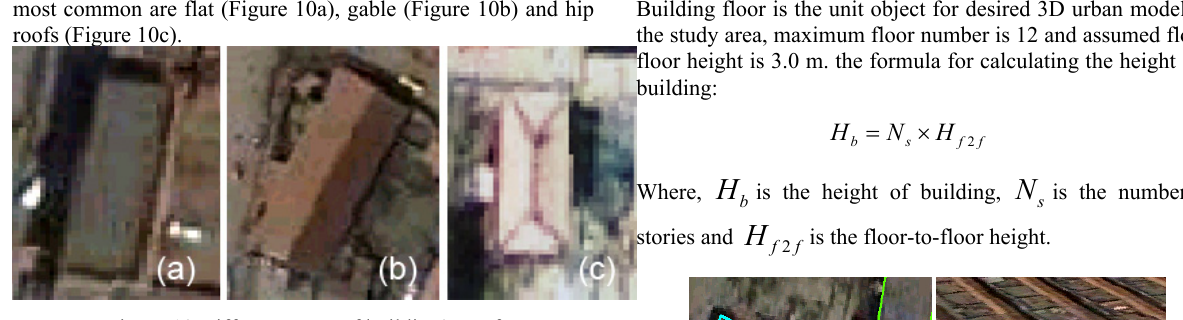
Figure 10 Different types of building’s roof